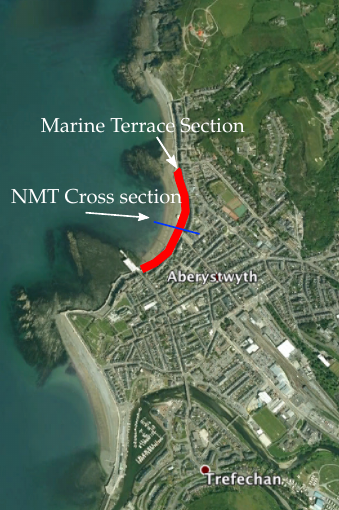
Figure 2. Map showing the Aberystwyth promenade and North Marine Terrace (NMT) cross section.